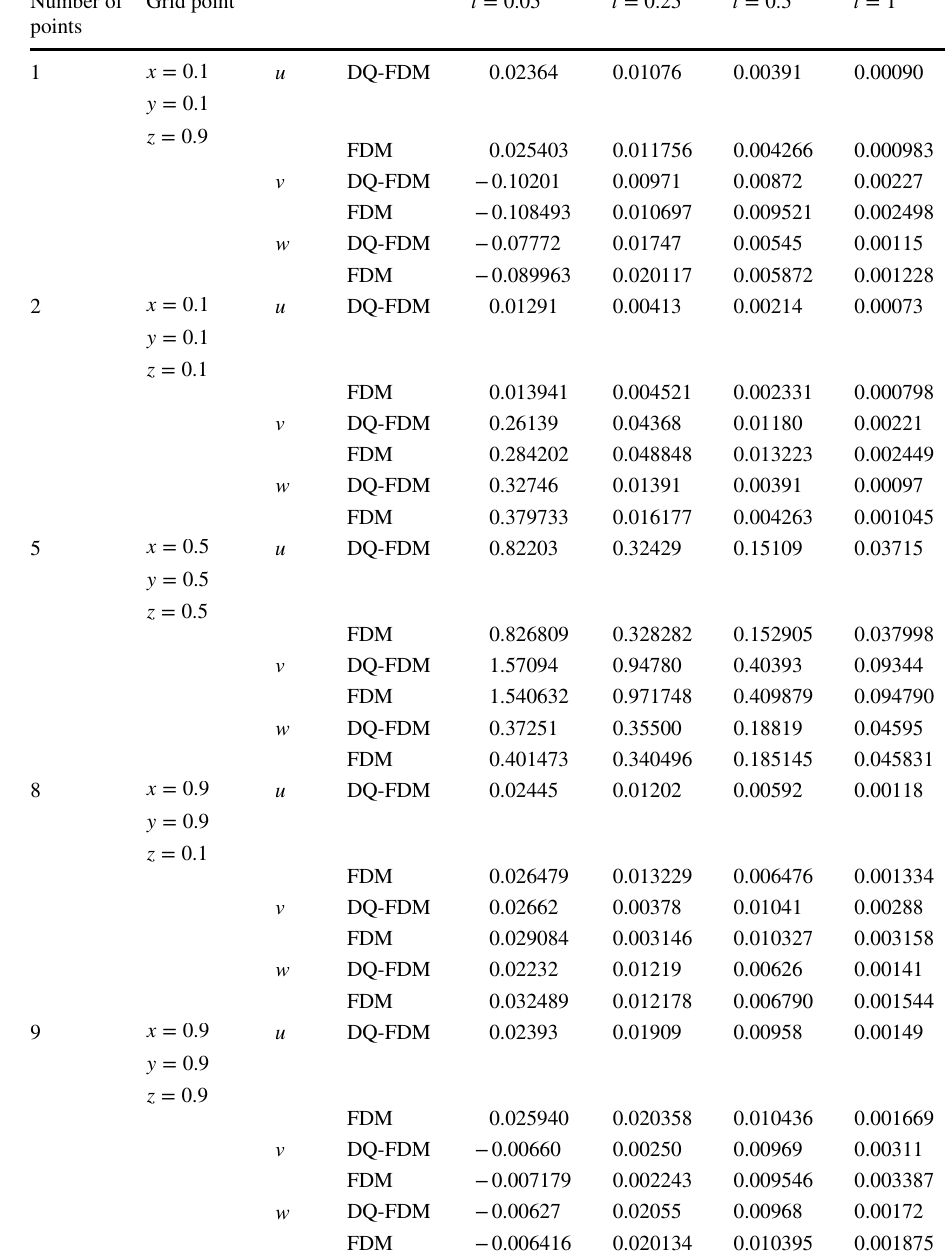
Number of Grid points 𝜐 = 0.1 and